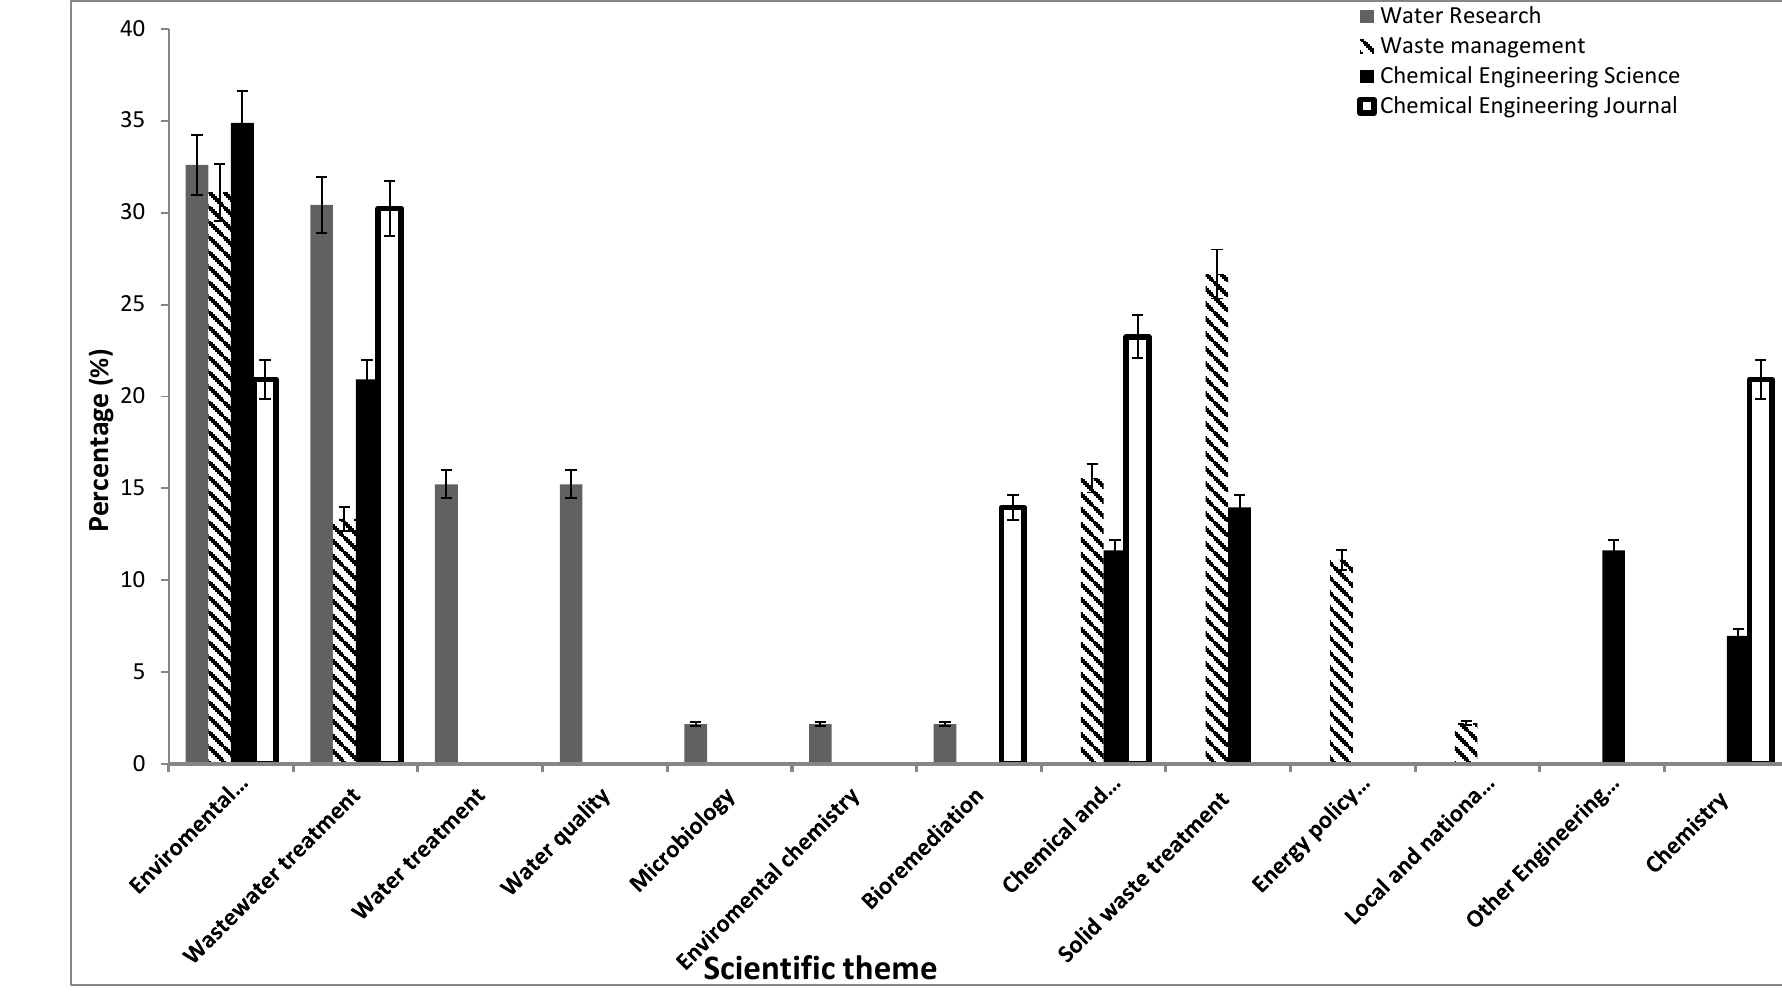
Figure 3. Scientific theme distribution of the analysed published manuscripts.